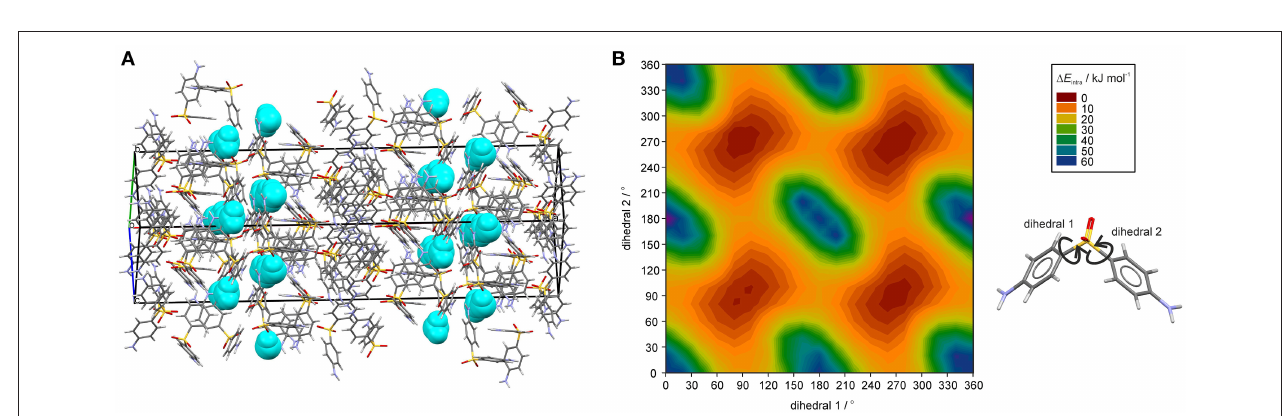
FIGURE 8 | Data derived from moisture-dependent PXRD measurements and Rietveld refinement showing (A) the change in cell volume with RH und (B) factional occupancy factor of the water molecule vs. cell volume in 0.33-Hy . In (C) an overlay of the hydrate at 90% (in blue) and 1% RH (red) is shown. H-atoms are omitted for clarity.